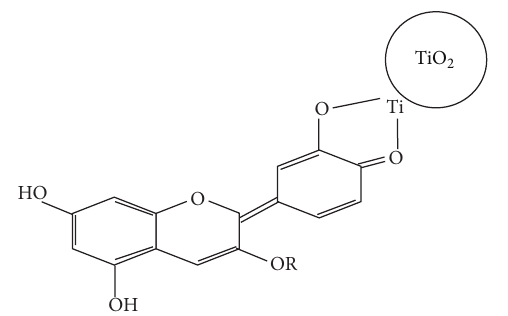
Figure 12: Graph of 𝐼 - 𝑉 characteristic of photovoltaic solar cell, namely, U1 (without ultrasonic process and no additive), U2 (with- out ultrasonic process and additive), U3 (ultrasonic process and no additives), and U4 (ultrasonic process and